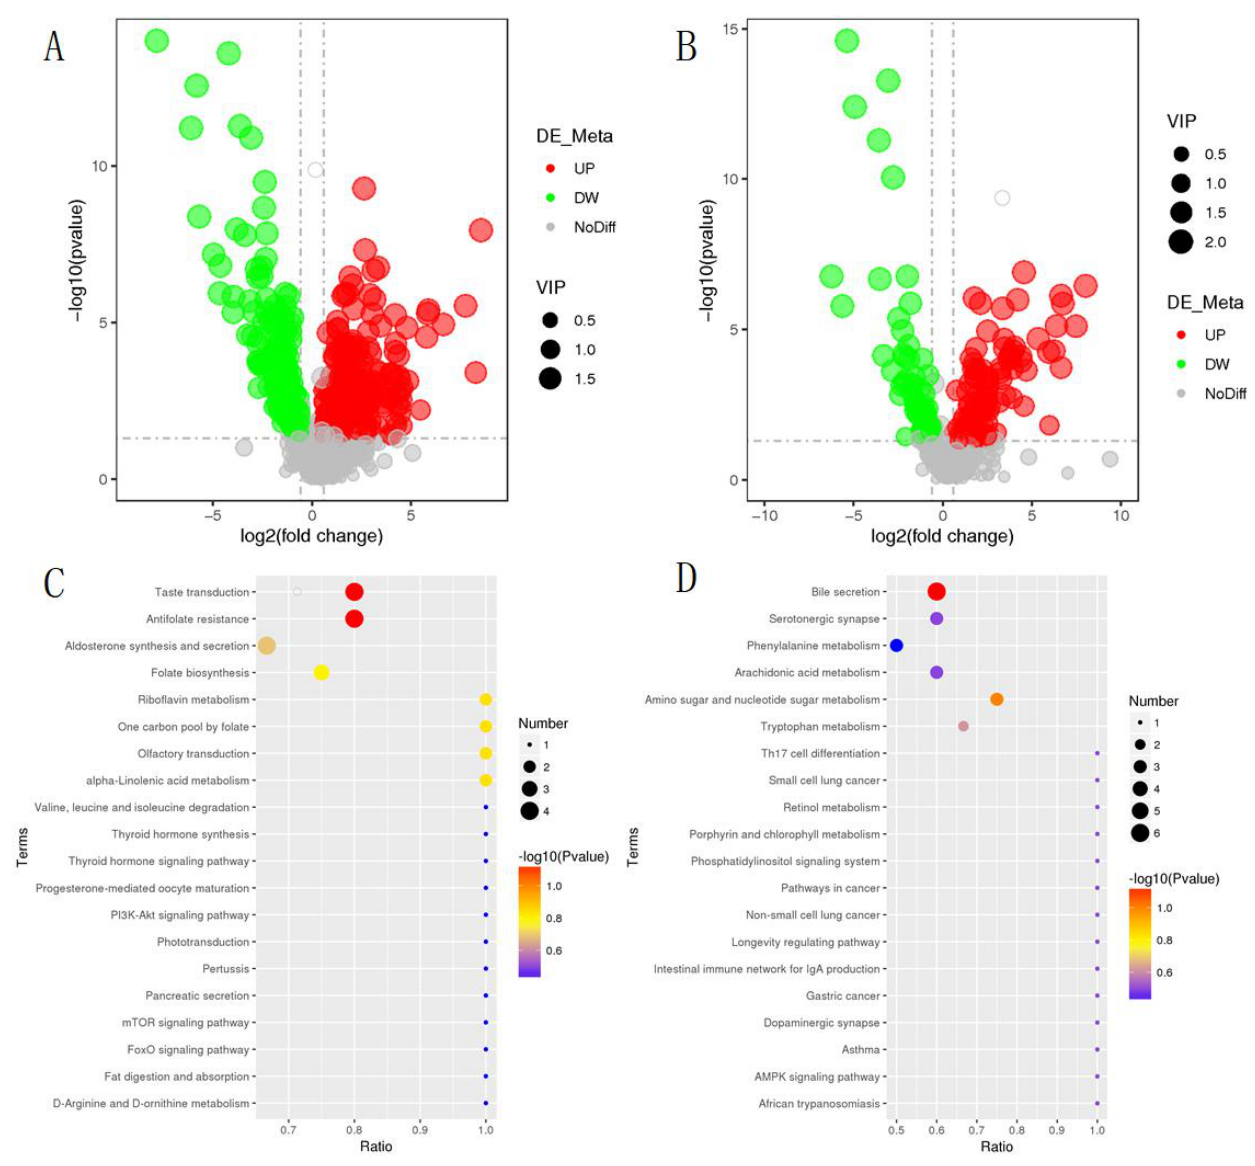
Figure 5. Differential metabolites and metabolic pathways in cecal feces of diarrhea-afflicted rabbits. ( A , B ) Volcano of metabolites with significant differences between Dia_Ce and Con_Ce, where A is a positive ion mode and B is a negative ion mode. ( C , D ) KEGG enrichment bubble diagram, where C is a positive ion mode and D is a negative ion mode.